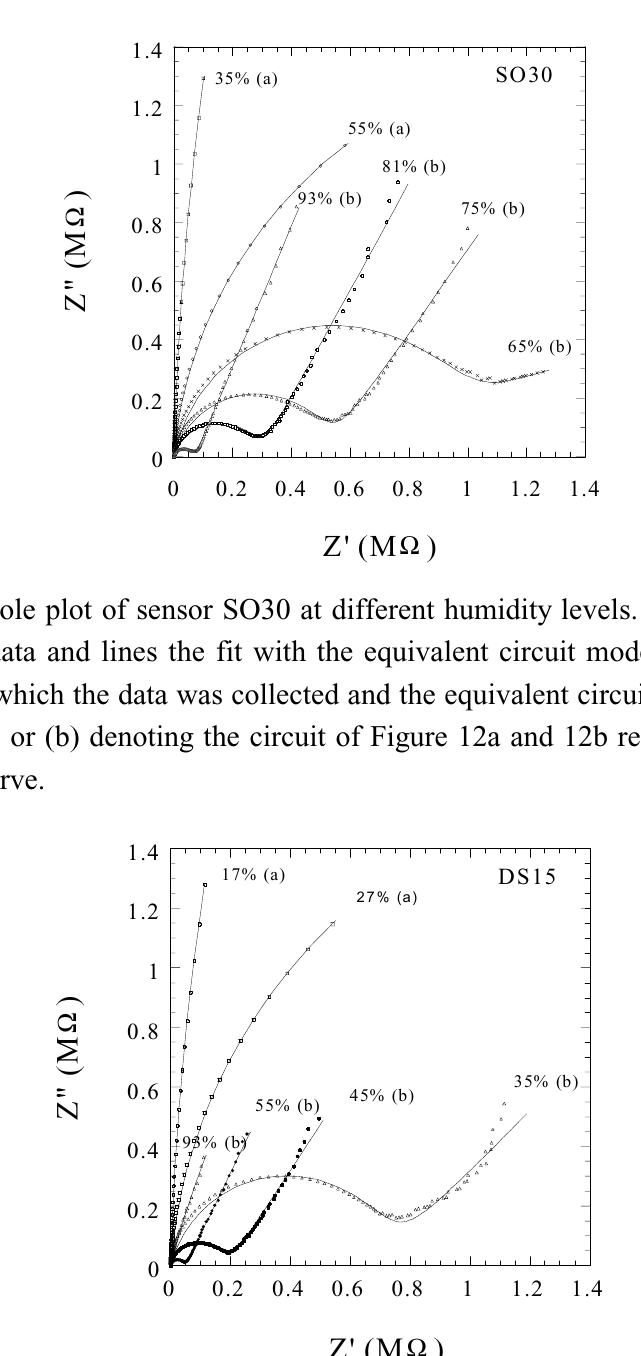
points of inflection seen in Figure 6.